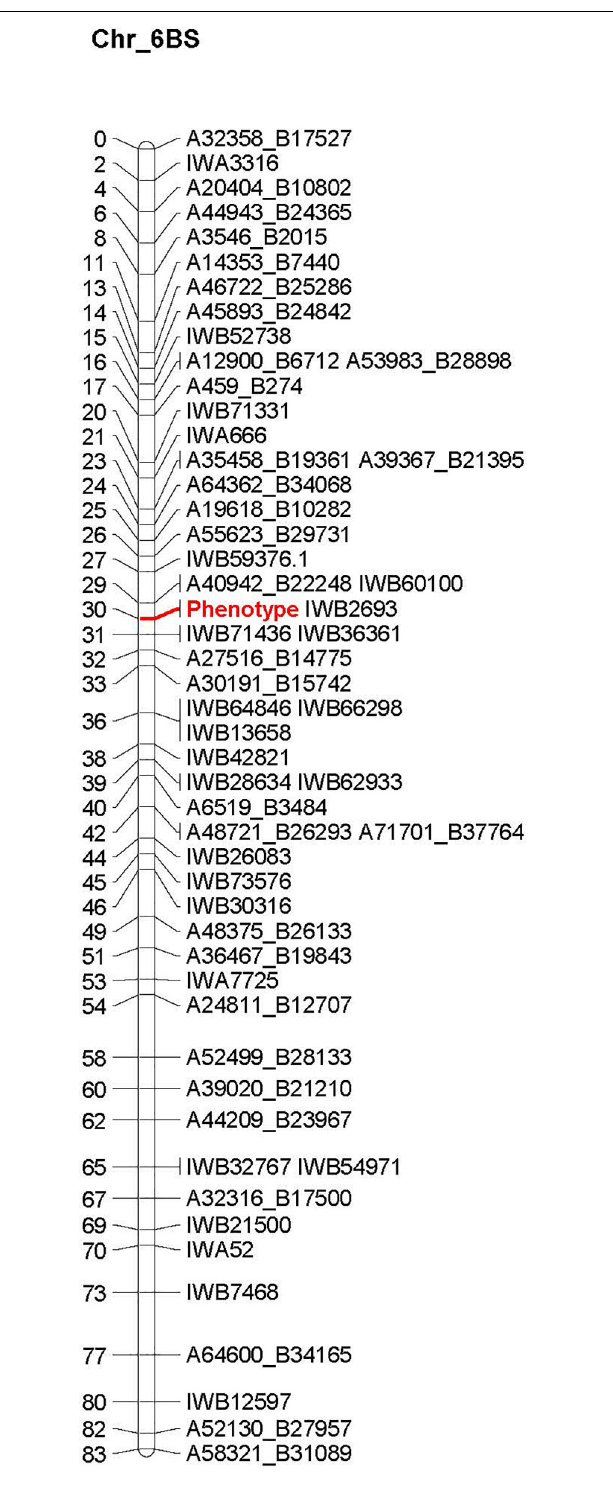
FIGURE 2 | Linkage map showing location of the Hessian fly resistance locus on chromosome 6B. Marker “Phenotype” listed in red represents the marker created from converting the Hessian fly screening results within the 180 recombinant inbred lines into a binary response. Number of the left-hand side of the chart is the chromosomal distance in